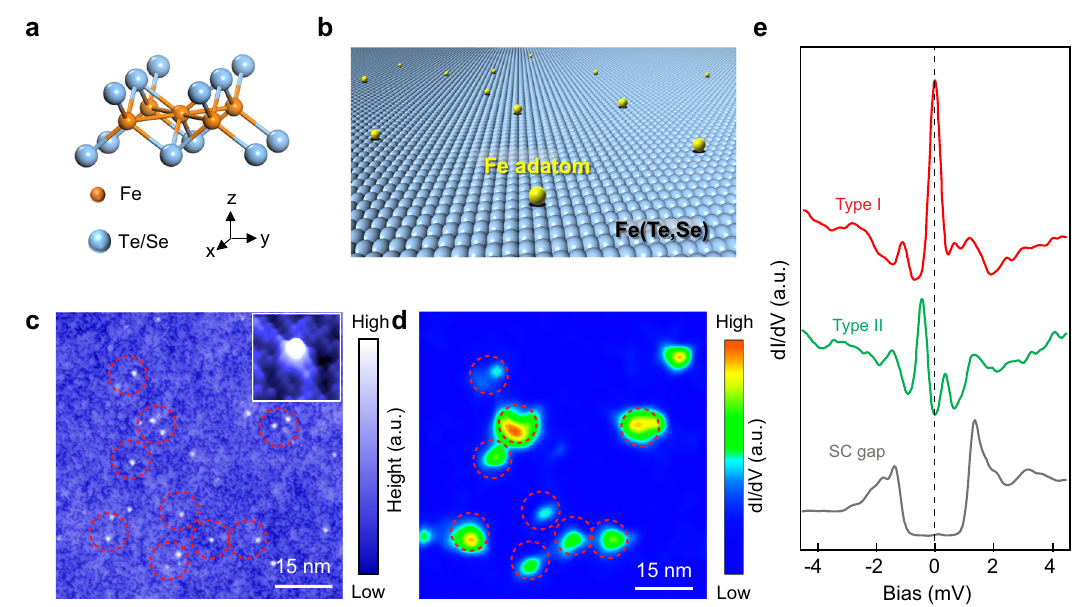
Fig. 1 Characterization of deposited Fe adatoms on FeTe 0.55 Se 0.45 surface. a Crystal structure of Fe(Te,Se). b Schematics of Fe adatoms deposited on the surface of FeTe 0.55 Se 0.45 . The adsorption sites are random, including both on and off of the C 4 symmetric sites in the center of four Te/Se atoms and at various heights above the surface (Supplementary Note 1). c A STM image ( V s = − 10 mV, I t = 100 pA) after atomic Fe atom deposition. The bright dots correspond to Fe adatoms with a coverage of 0.04%. Inset: A 4 × 4 nm atomic-resolution topographic image showing a single-Fe adatom located at a high- symmetry site. d A d I /d V map ( V s = − 10 mV, I t = 100 pA) of c at zero energy. The high conductance areas and the Fe adatom positions are in good spatial correspondence, as highlighted by the red dashed circles. e Typical d I /d V spectra ( V s = − 10 mV, I t = 200 pA) showing the zero-bias peak on type-I Fe adatoms (red curve), YSR states (green curve) on type-II Fe adatoms, and the clean superconducting (SC) gap away from the adatoms (gray